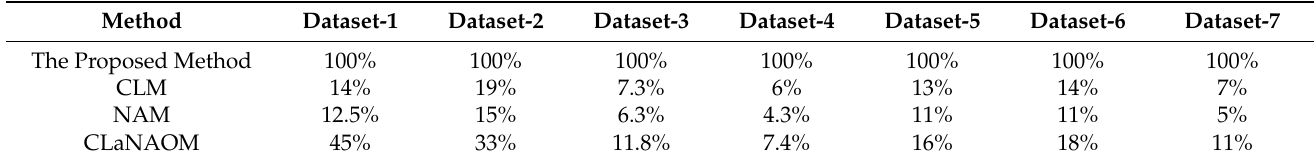
Table 25. The extraction rate in each method for Datasets 1–7.